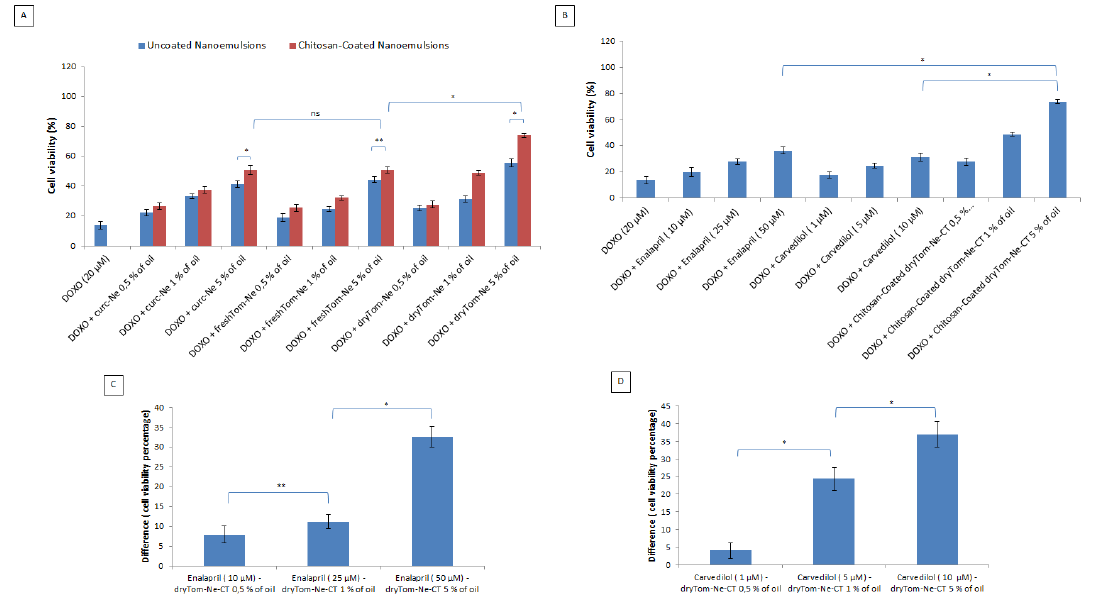
Figure 3. Cell viability in function of the concentration of nutraceutical-loaded uncoated and chitosan-coated nanoemulsions all tested at concentrations from 0.5 to 5% v / v of oil tested combined with doxorubicin at 20 µ M. ( A ). The viability of cardiomyoblasts incubated with doxorubicin (at 20 µ M) in association with Enalapril at 10, 25 and 50 µ M and Carvedilol at 1, 5 and 10 µ M. ( B ). Difference in the percentage of cell viability versus control cells, between ( C ) Enalapril and ( D ) Carvedilol and the best nanoemulsion (dryTom-Ne-CT) at different concentrations * p < 0.001; ** p < 0.05; ns: not significant.